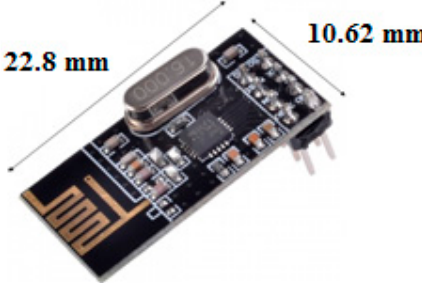
Figure 3. RF module NRF24L01.